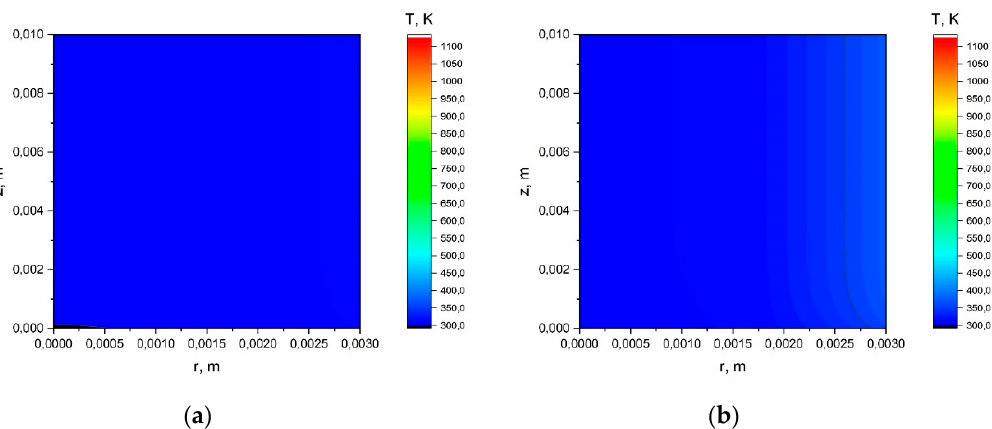
Figure A13. Temperature distribution in the stem of a herbaceous plant: R = 0.003 m, t = 6 s, q = 0.5